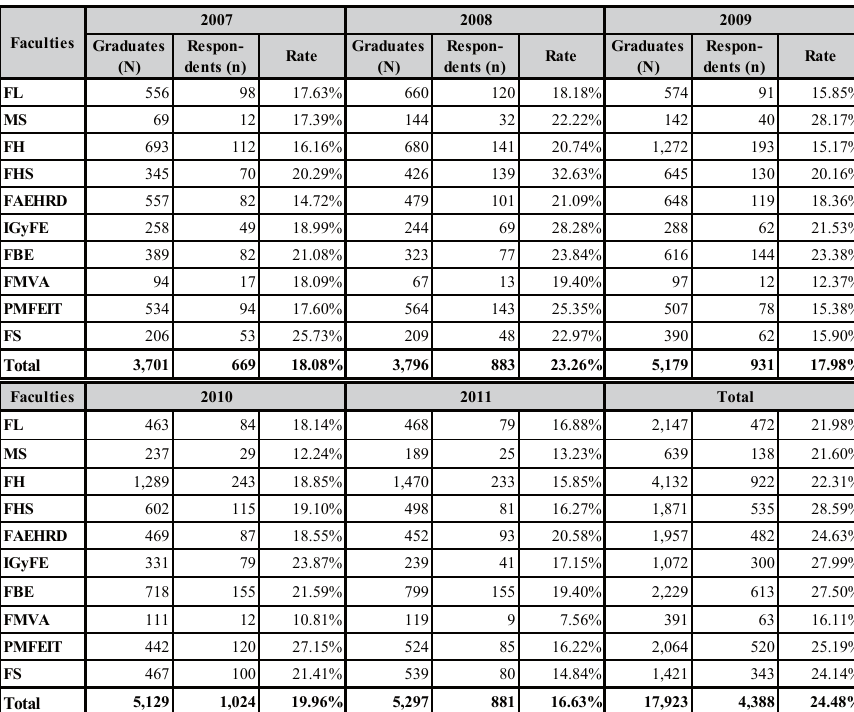
Table 1. The Graduate Follow-Up System data and sample size by faculties,